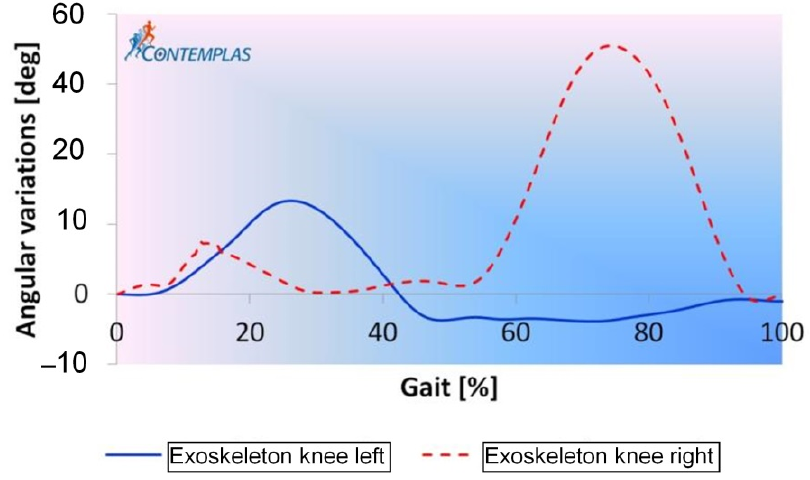
Figure 28. Exoskeleton knee joints angular variation for a complete gait without foot and ground contact.